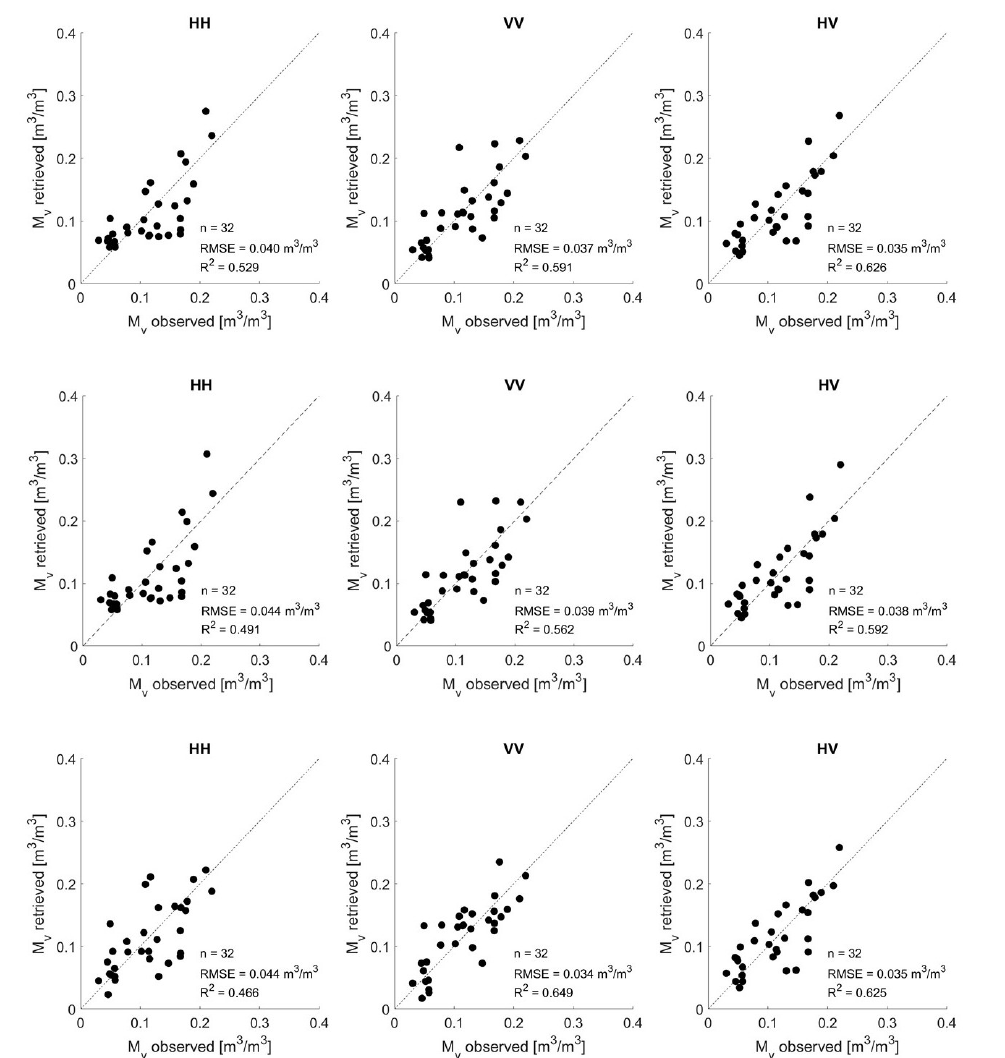
Figure 10. Simulated field-average soil moisture values based on effective roughness modeling for the Oh model and AIEM against observed field-average soil moisture values for HH ( left ), VV ( middle ) and HV ( right ) polarization. The top line represents the first validation technique performed with the Oh model. The middle line represents the second validation technique, i.e., leave-one-out cross- validation, performed with the Oh model. The bottom line represents the first validation technique performed with the